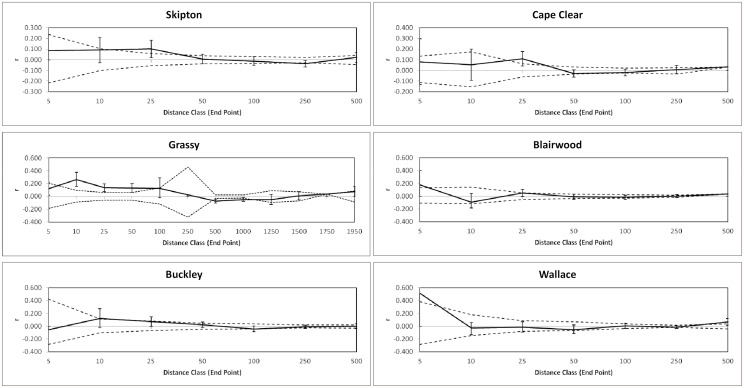
Spatial autocorrelation coefficient values (r) for Allocasuarina verticillata populations where significant structure was observed.Dashed lines indicate upper and lower 95% CI around r based on 9999 simulations; 95% confidence bars around r from 9999 bootstraps. Linear populations left panels, patch populations right panels.